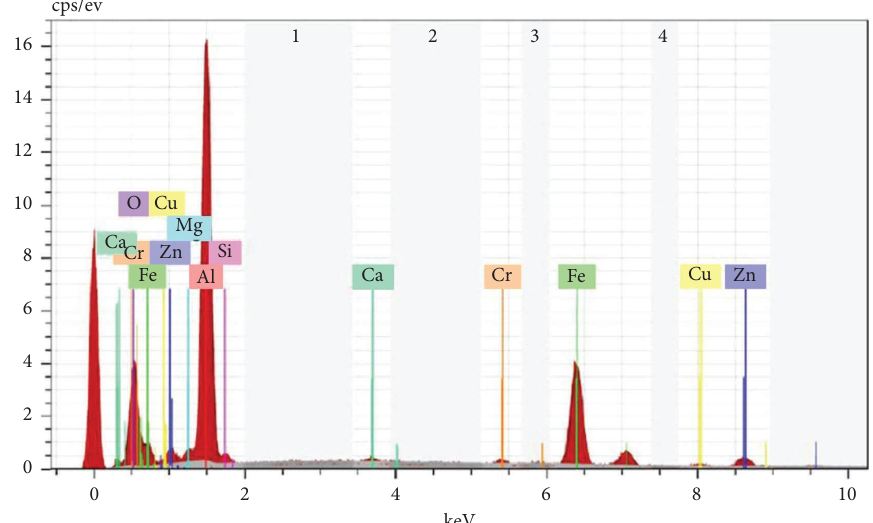
Figure 4: EDAX analyses of Al 7075 and composite with 7.5 wt.% basalt reinforcement